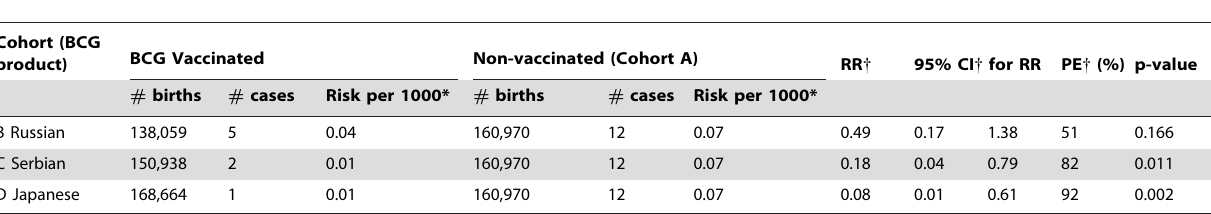
Table 3. BCG vaccine prevention effectiveness for culture positive TB cases, Kazakhstan, 2002–2008.